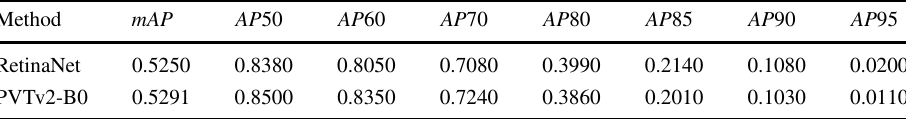
Table 3 Ablation experiments of PVTv2 on